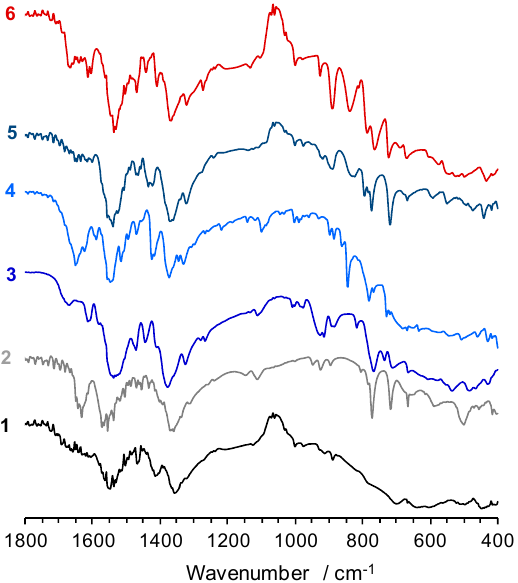
Figure 7. FTIR absorption spectra of the compounds 1 – 6 , showed in the wavenumber region between 1800 and 400 cm − 1 .